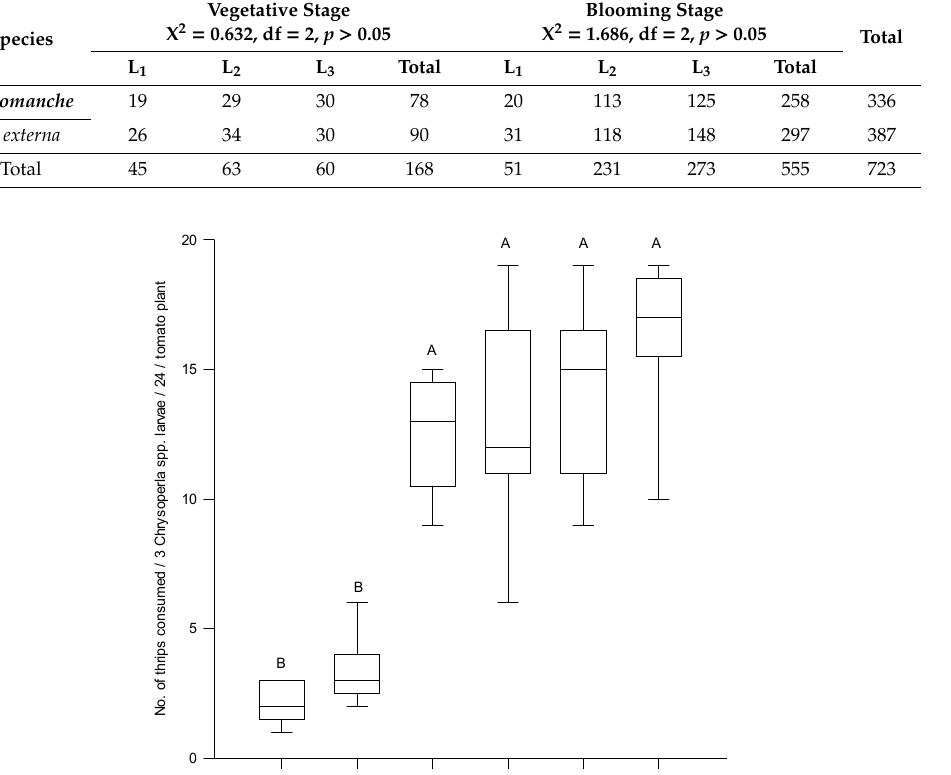
Figure 1. Number of thrips consumed by C. externa and C. comanche first, second and third instar larvae on tomato plants during blossom. Data are Q 1 < median < Q 3 . KW, H = 39.56, df = 5, p > 0.001. Bars topped by the same letter are not different (Holm–Sidak, p > 0.05). C = C. comanche , E = C. externa . First, second and third instar are represented by 1, 2 and 3, respectively.